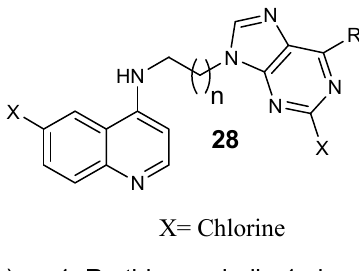
Figure 12. Structure of 4-aminoquinoline-purine hybrid compounds 28a – f.